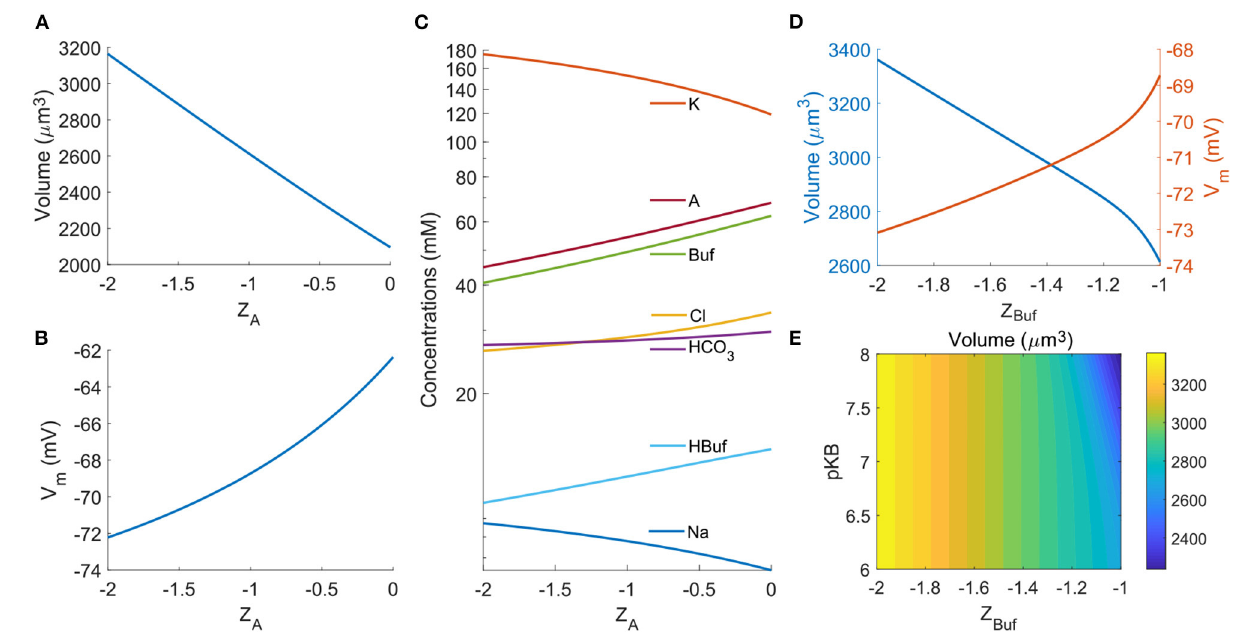
FIGURE 9 | Impact of Z A and Z Buf . (A) Cell volume as a function of Z A . (B) Membrane potential as a function of Z A . (C) Intracellular ion concentrations as function of Z A . (D) Cell volume and Membrane potential as functions of Z Buf . (E) Contour of the cell volume as a function of the effective p K B and Z A